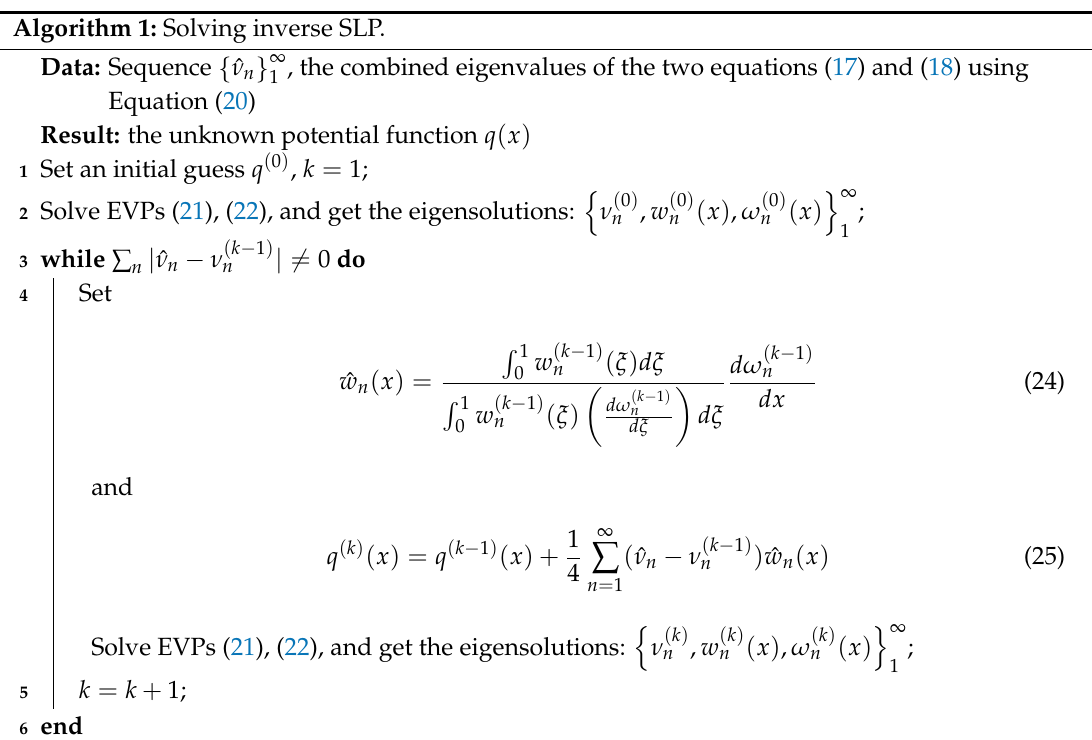
Algorithm 1: Solving inverse